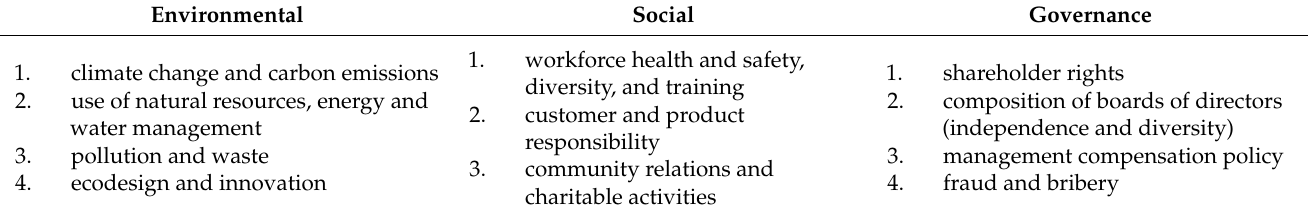
Table 2. Chosen problems within the framework of environmental, social and corporate gover- nance